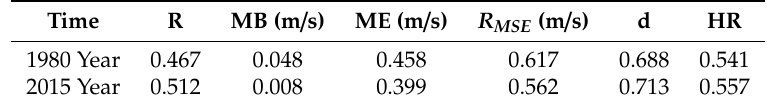
Table 10. Analysis of the 10-m wind speed simulation results using land-use data from 1980 and 2015. Time R MB (m / s) ME (m / s) R MSE (m / s) d